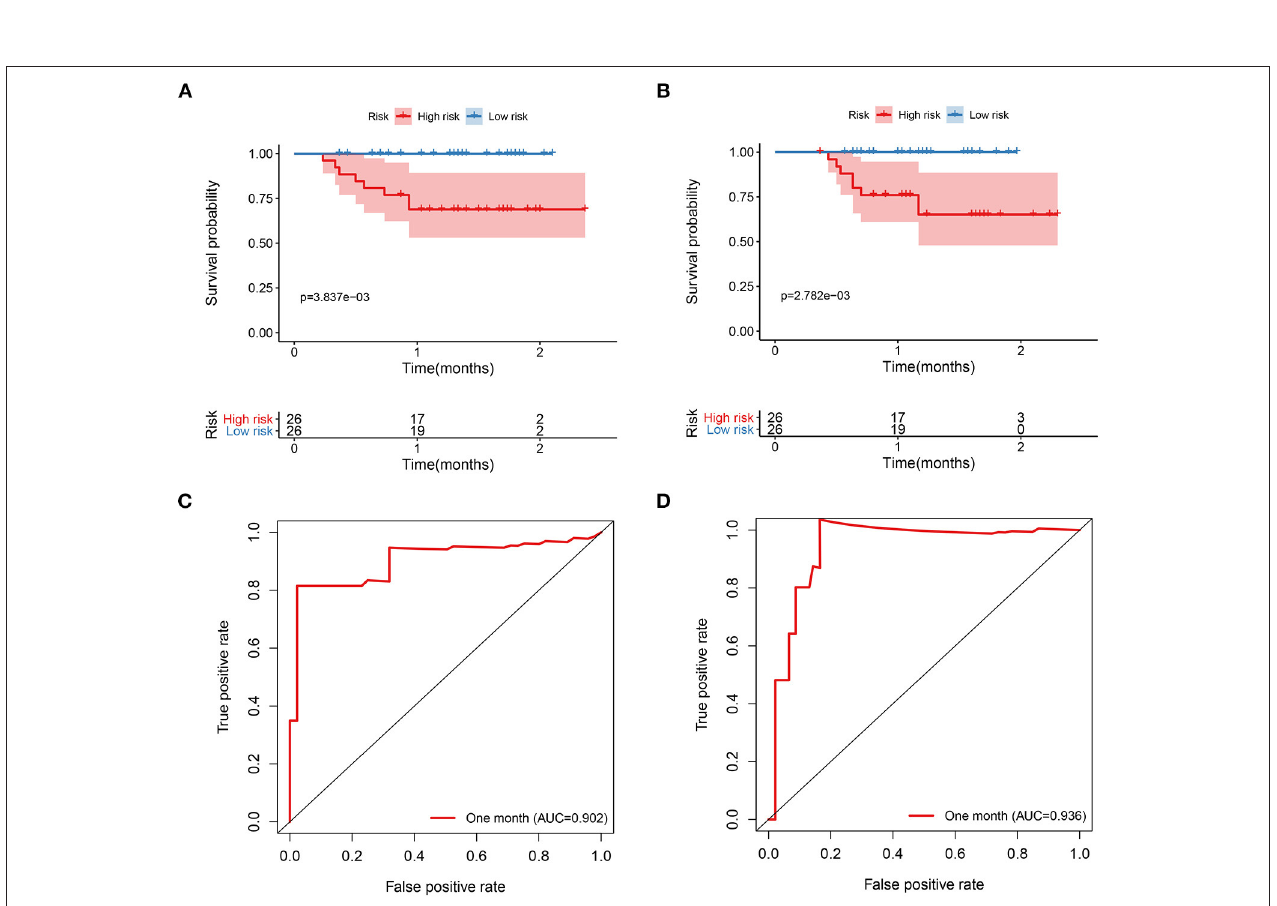
FIGURE 7 | The prognostic signature is associated with the survival of patients with COVID-19. (A) The K–M curves analysis of COVID-19 patients that stratified patients by median risk score in the training dataset. (B) The K–M curves analysis of the COVID-19 patients that stratified patients by median risk score in the testing dataset. (C) The ROC analysis of the prognostic signature in the training dataset. (D) The ROC analysis of the prognostic signature in the testing dataset.